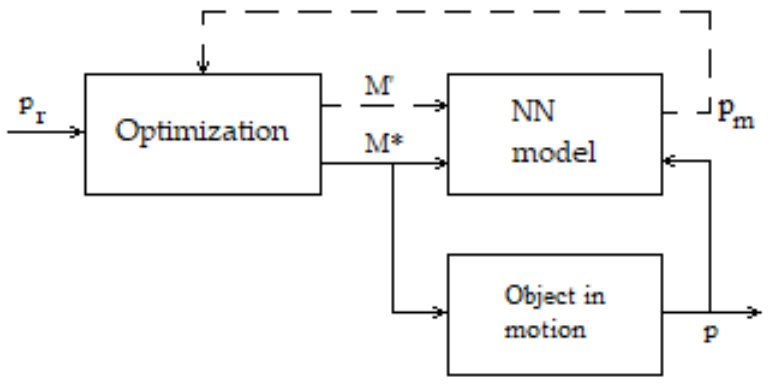
Figure 15. The neural predictive control structure.